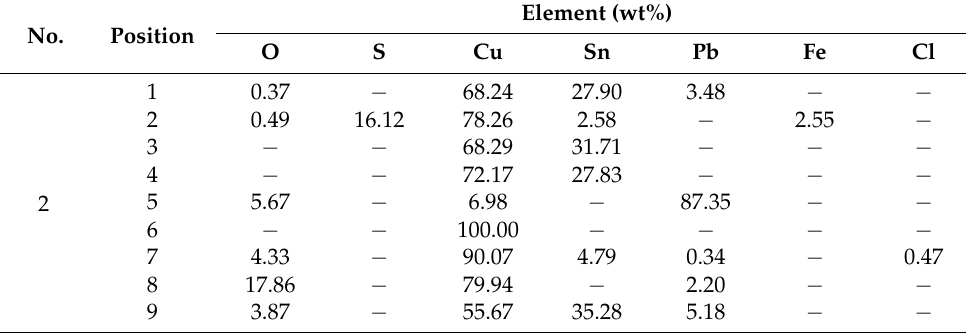
Table 2. Ga-31 (No. 2) microstructure energy dispersive spectrometer (EDS) results.